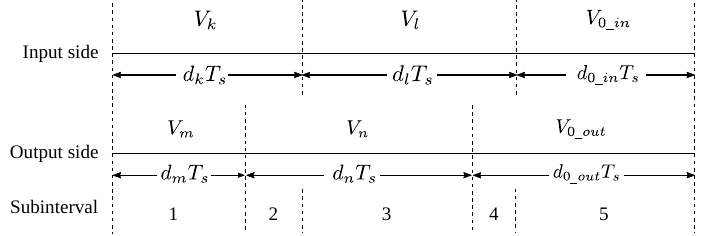
Figure 17. Switching sequence divided into five subintervals.